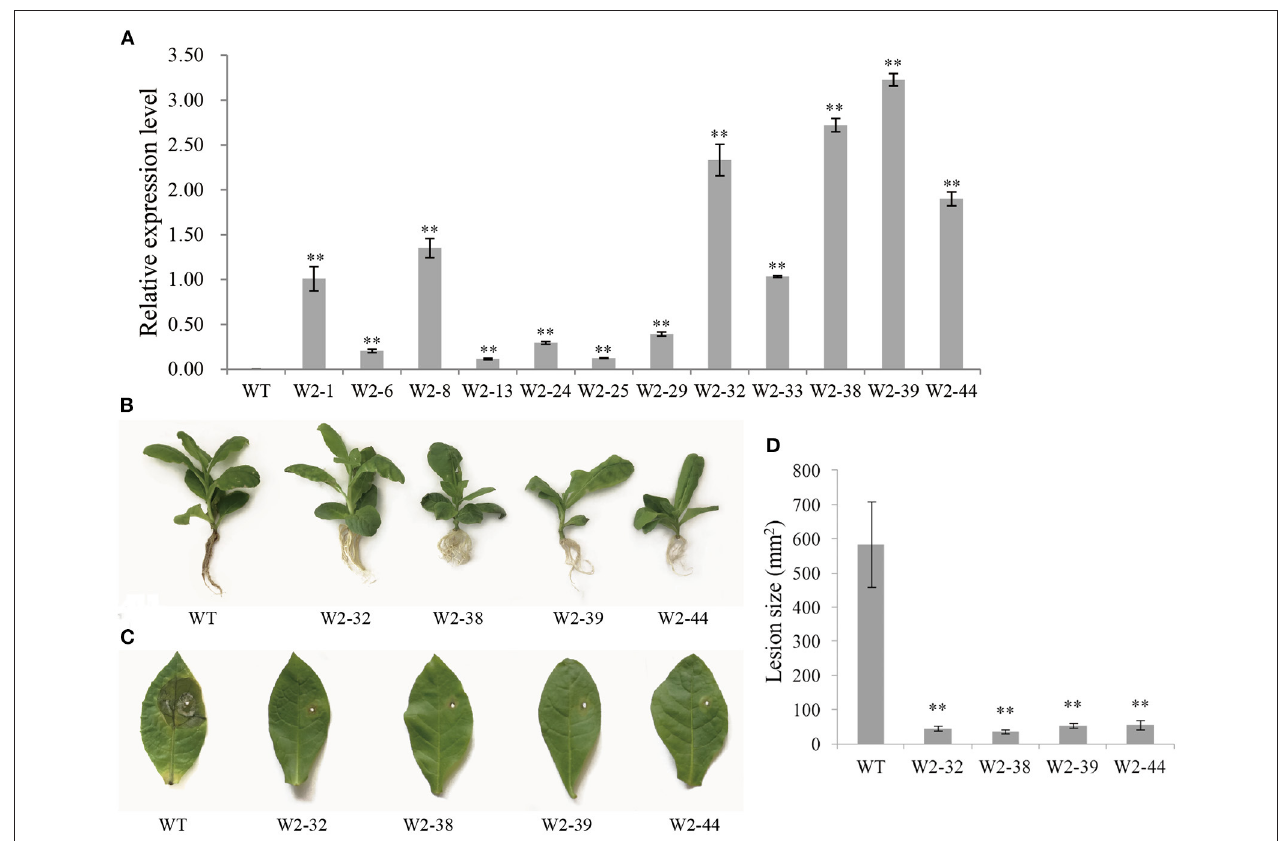
FIGURE 2 | Gene expression and resistance analyses of T 2 generation LrWRKY2 transgenic tobacco lines. (A) The LrWRKY2 was stably expressed in the 12 T 2 generation LrWRKY2 transgenic tobacco lines (W2-1/6/8/13/24/25/29/32/33/38/39/44). (B) The root inoculation assay revealed the enhanced resistance of four T 2 LrWRKY2 transgenic tobacco lines (W2-32/38/39/44) to F. oxysporum infection. (C) The leaf inoculation assay revealed the increased resistance of four T 2 LrWRKY2 transgenic tobacco lines (W2-32/38/39/44) to F. oxysporum infection. (D) The lesion areas in the inoculated leaves of the four T 2 LrWRKY2 transgenic tobacco lines were significantly smaller than that in the WT (** p < 0.01). Bars represent the standard errors of three biological replicates, and the statistical analysis was performed with the t test (** p <